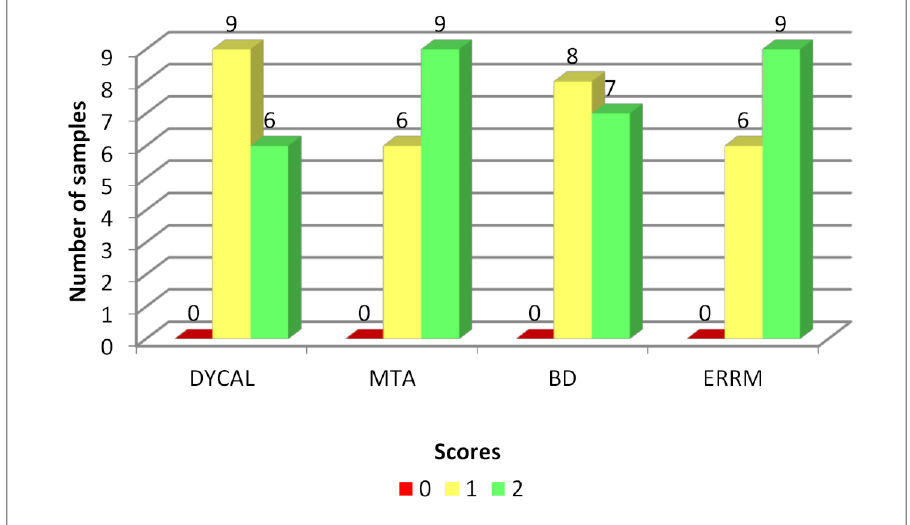
Figure 3. CT scan dentinal bridge comparison among the pulp-capping agents (0—no dentinal bridge formation; 1—islands of calcified material; 2—complete dentinal